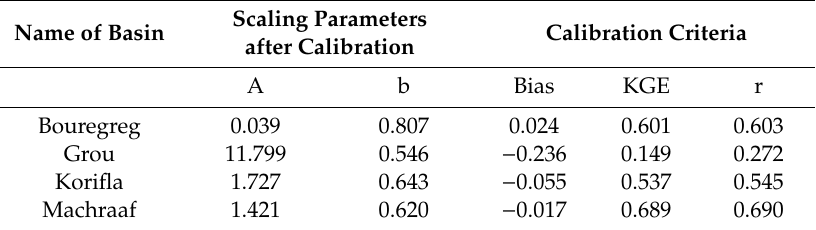
Table 13. Model calibration results for the four stations studied by KGE.